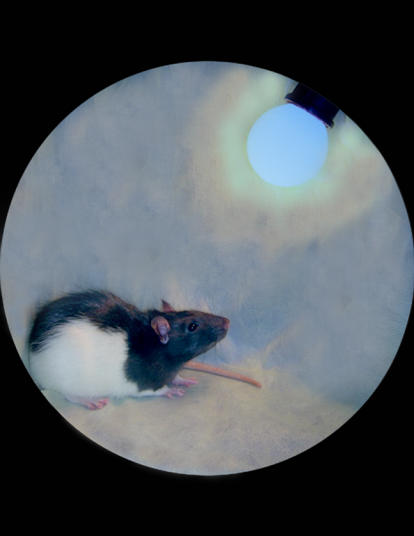
Training rats to associate light with a traumatic experience helped researchers identify the mechanisms that allow the brain to link new memories with recollections. (Sophie Tronel and Ryan Corces-Zimmerman)